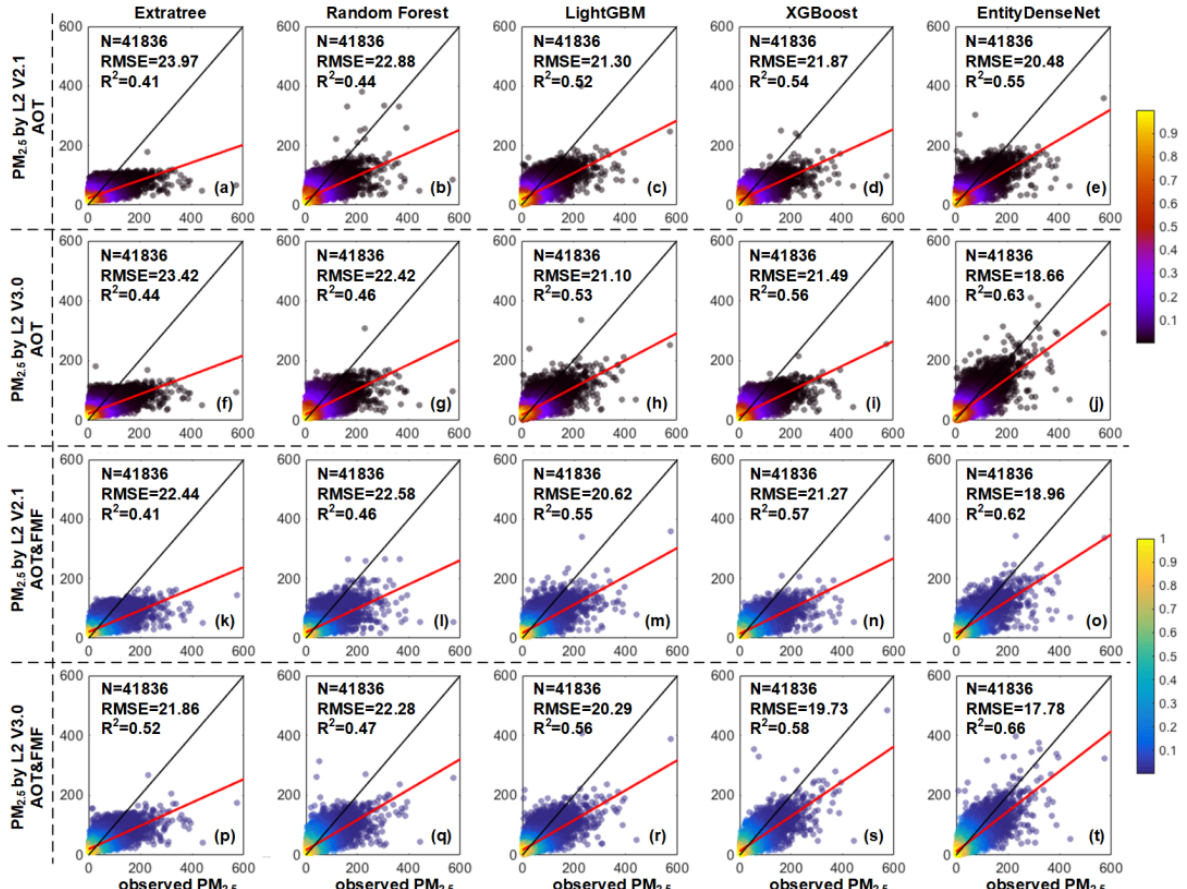
Figure 7. Density scatter plots of modeling results of ground-based PM 2.5 retrieved by five models: Extratree ( a , f , k , p ), Random Forest ( b , g , i , q ), LightGBM ( c , h , m , r ), XGBoost ( d , i , n , s ) and EntityDenseNet ( e , j , o , t ), based on four different input data (V2.1 and V3.0 data and AOT and AOT&FMF data). The black and red lines represent 1:1 and fitting lines, respectively.